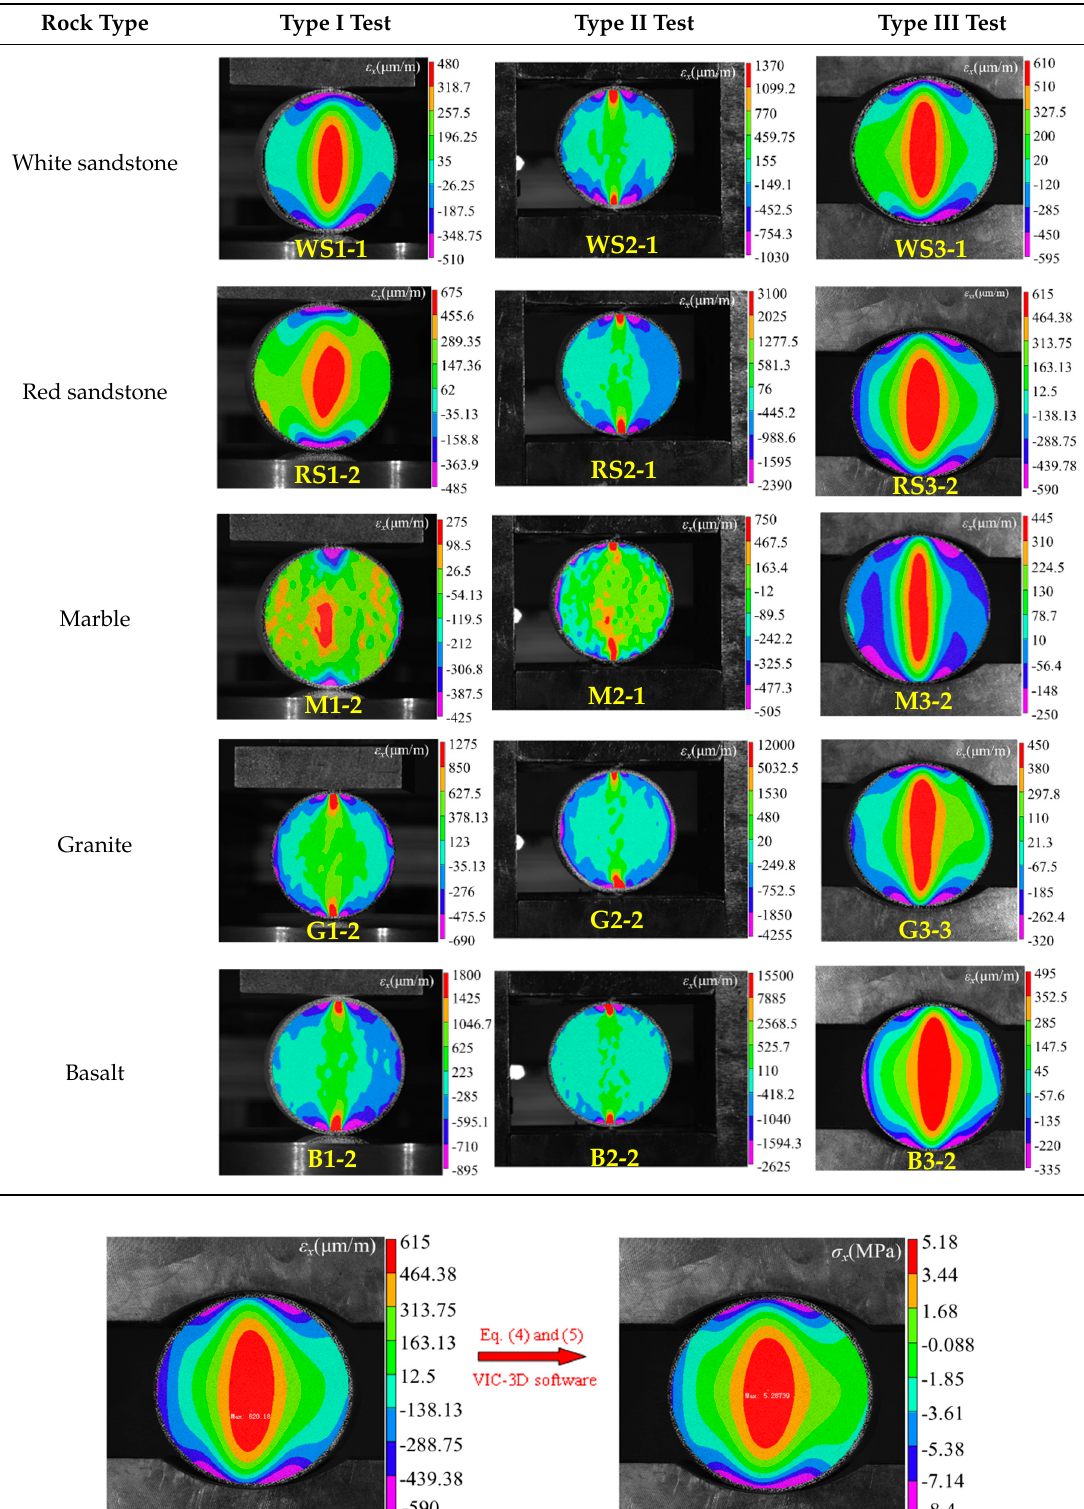
Table 3. The tensile strain contour plots of representative tested specimens prior to failure.